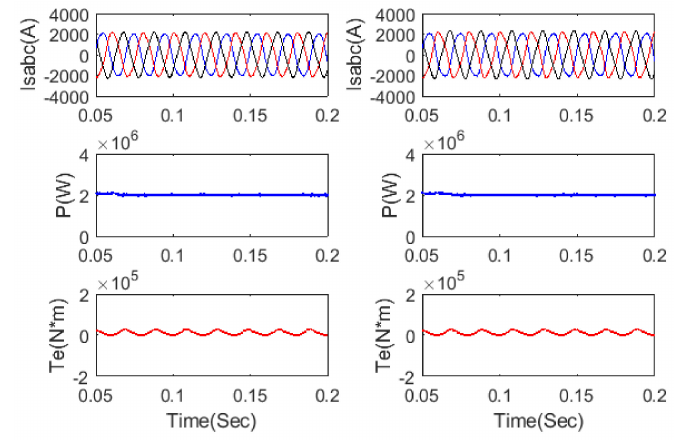
Figure 12. Responses with 50% L m , 50% Rs , 50% R r and 120% L m , 120% Rs, and 120% R